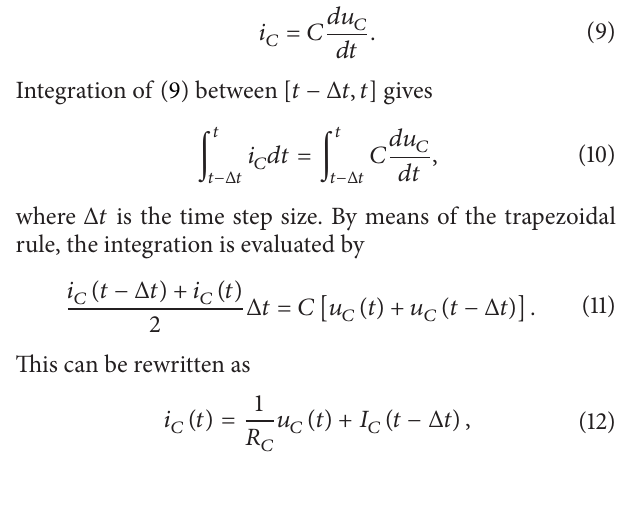
Figure 4: Approximate division of tower body.